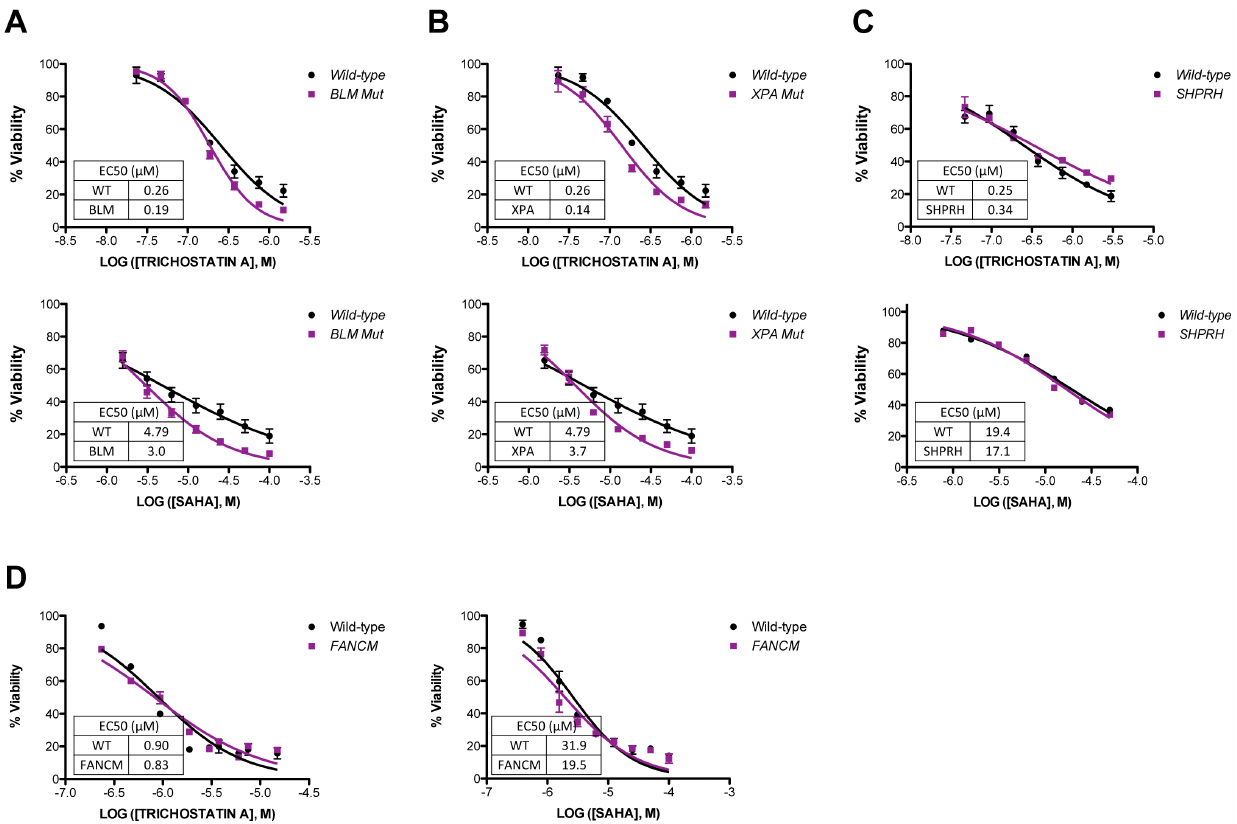
Figure 7. Effect of HDACi on the viability of mammalian cell lines. (A) BLM and (B) XPA human lymphocytes were treated with 0 to 1.5 m M TSA or 0 to 100 m M SAHA for 48 hours. (C) SHPRH MEFs were treated with 0 to 1.5 m M TSA or 0 to 100 m M SAHA for 48 hours. (D) FANCM human colorectal cancer cells were treated with 0 to 1.5 m M TSA or 0 to 100 m M SAHA for 48 hr. Viability was determined using CellTiter-Glo. The data represent the average of 3 independent experiments 6